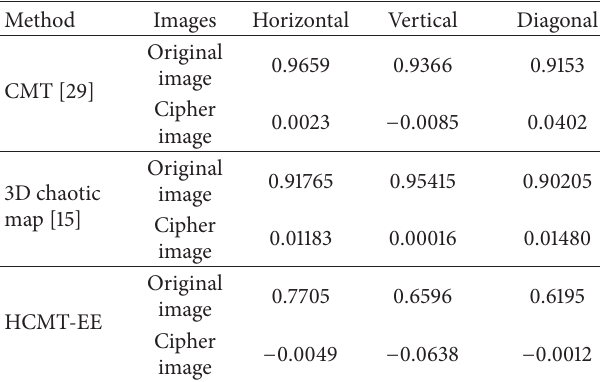
Table 2: This table shows pixel correlation of Lenna image with CMT, 3D chaotic map algorithm, and